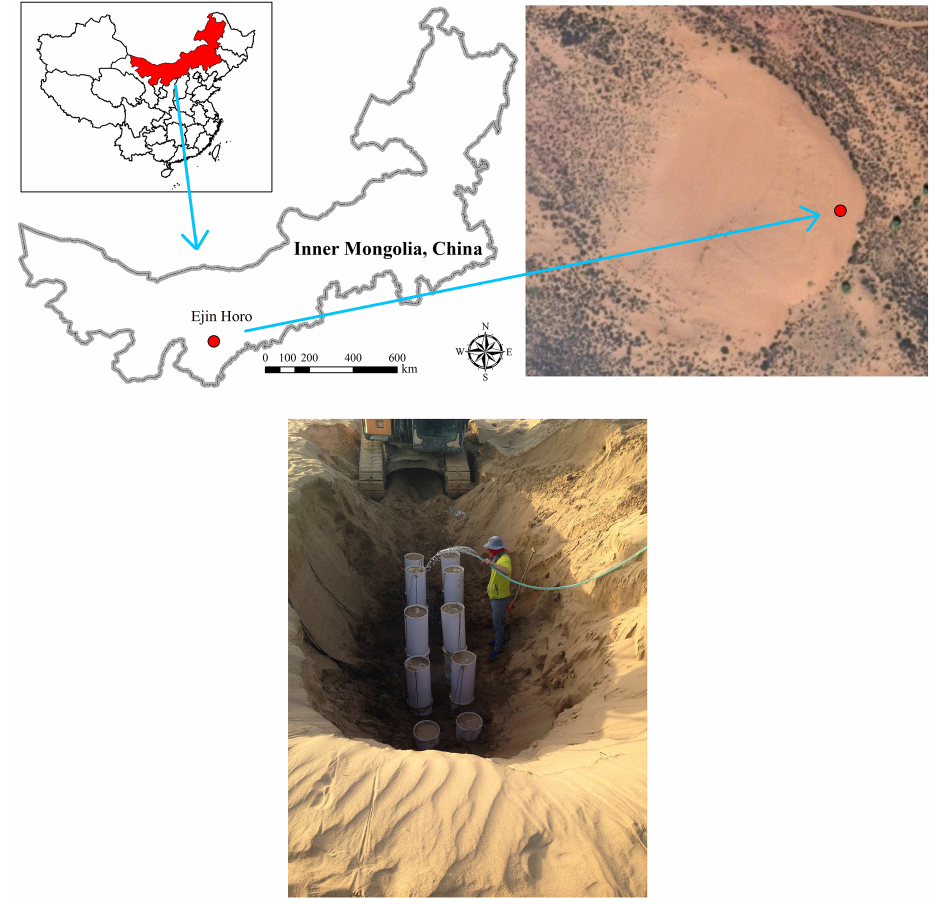
Figure 2. Geographic location of the experimental